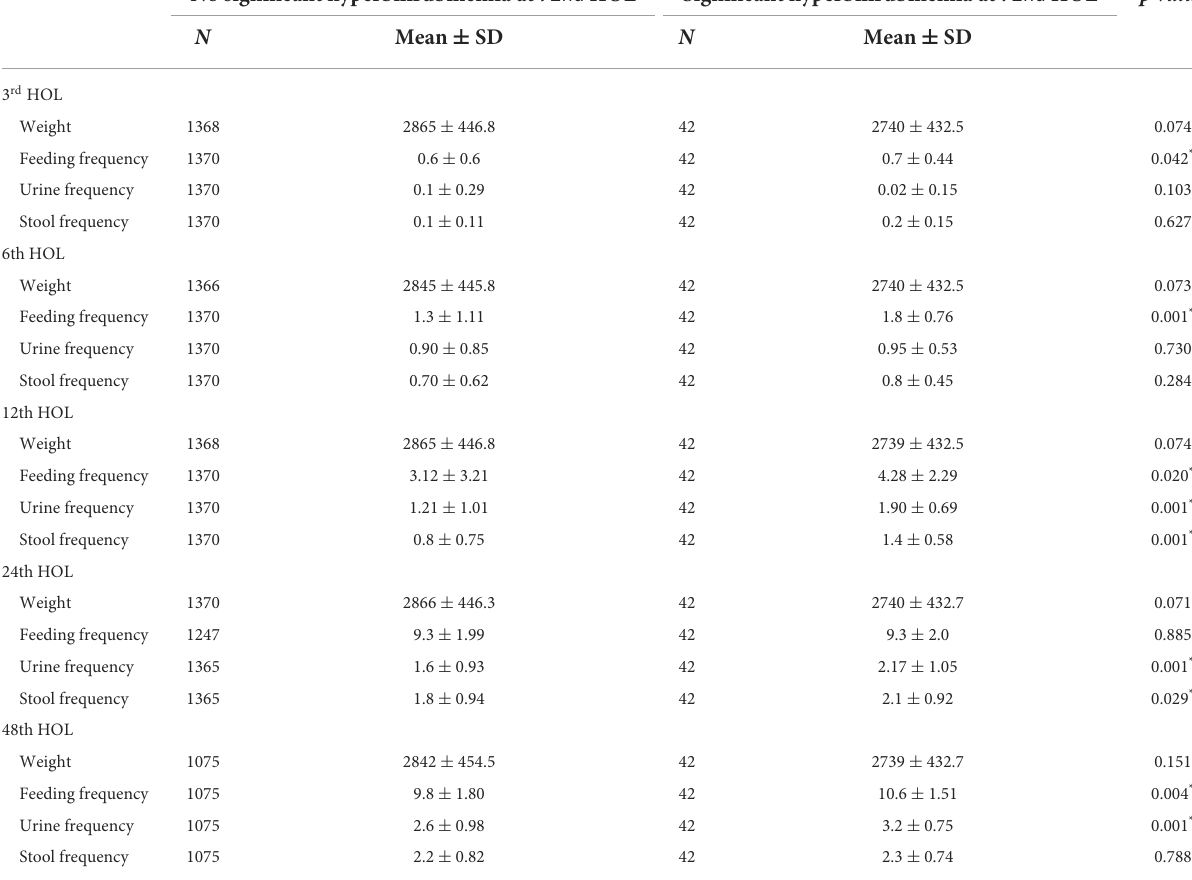
TABLE 6 Association of feeding pattern and significant hyperbilirubinemia at 72nd HOL. No significant hyperbilirubinemia at 72 nd HOL Significant hyperbilirubinemia at 72 nd